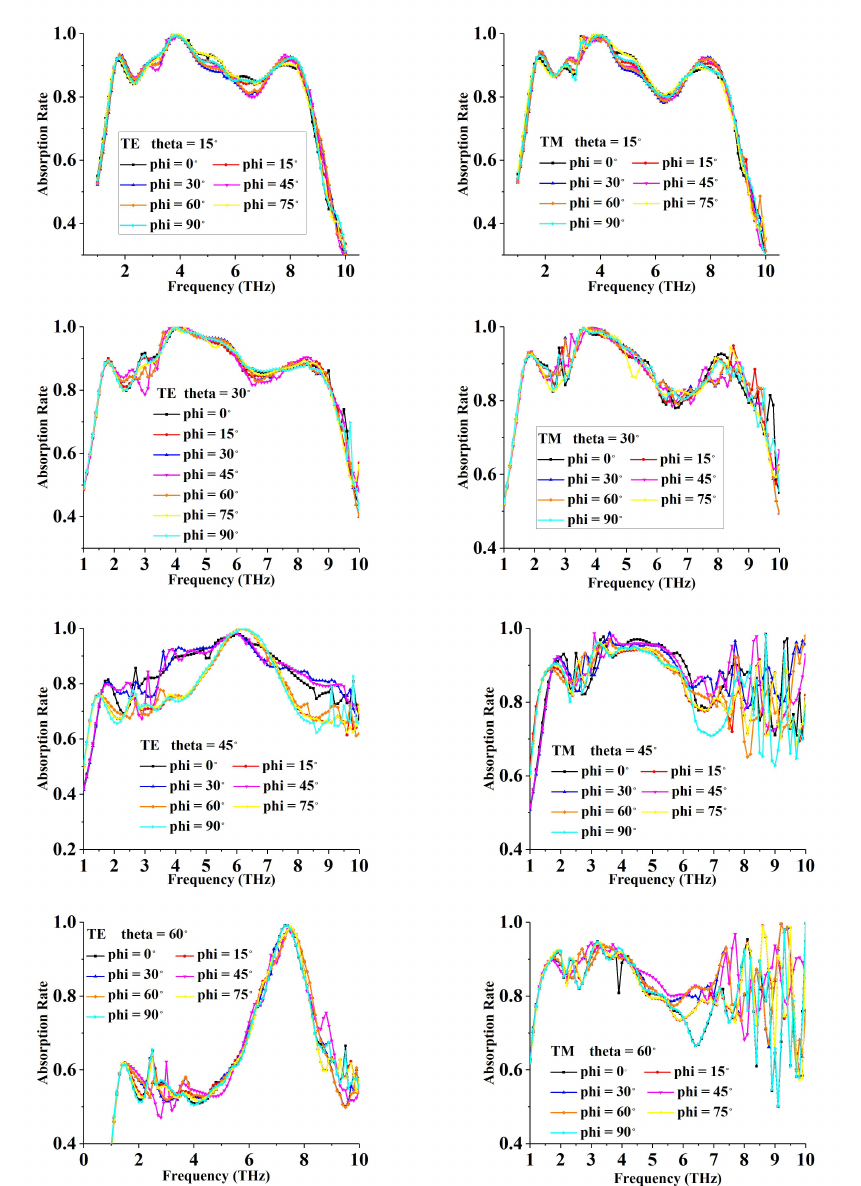
Figure 10. Simulated absorption spectra of the absorber for different polarization angles under various